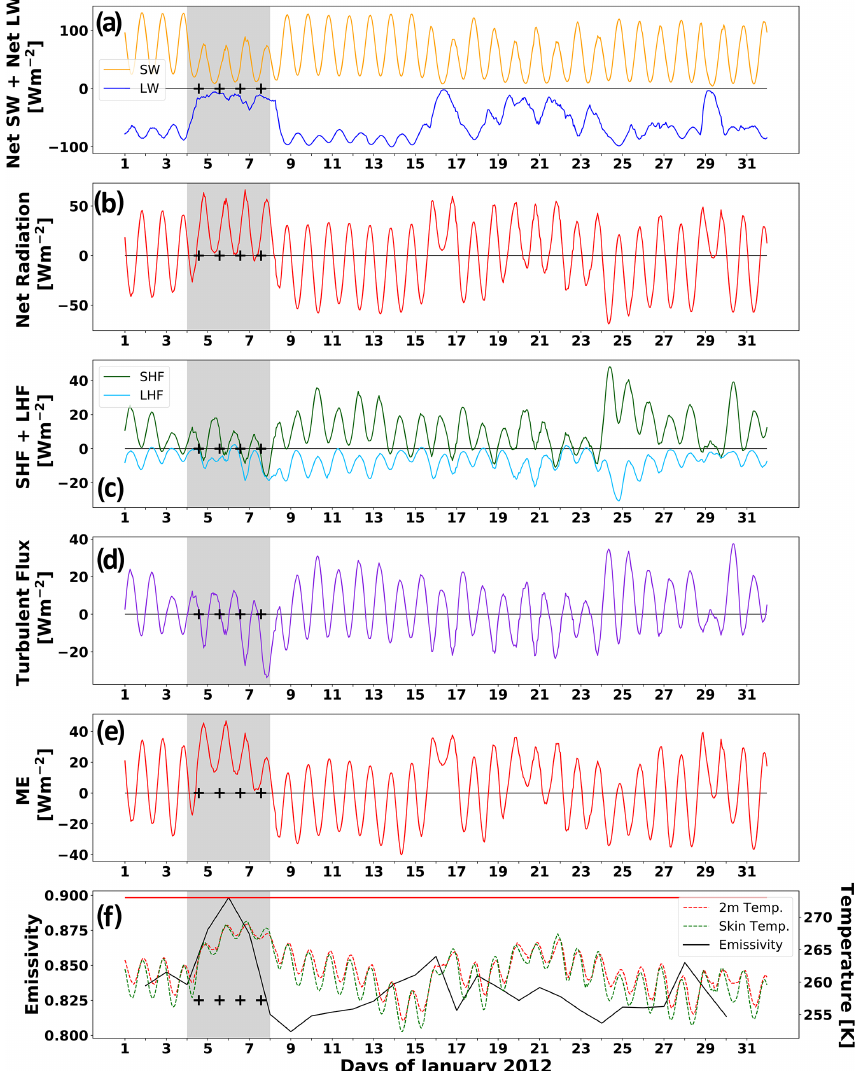
Figure 8. As in Fig. 4 but over the Pine Island and Thwaites Glacier region throughout January